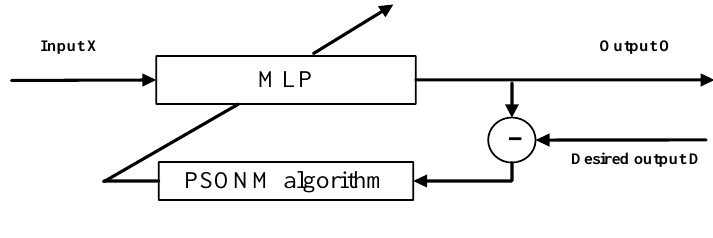
Figure 4. PSONHM-based MLP.